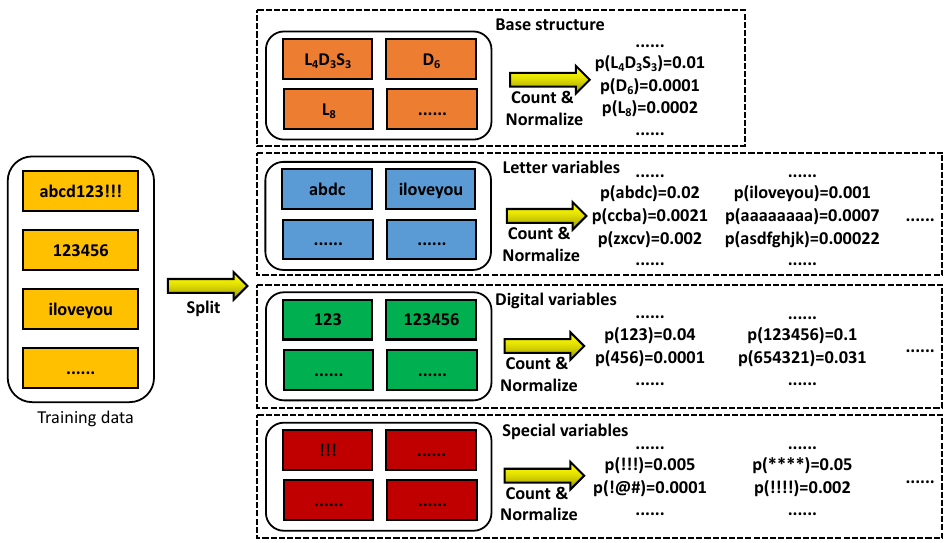
Figure 4. Schematic diagram of the LPG–PCFG model training